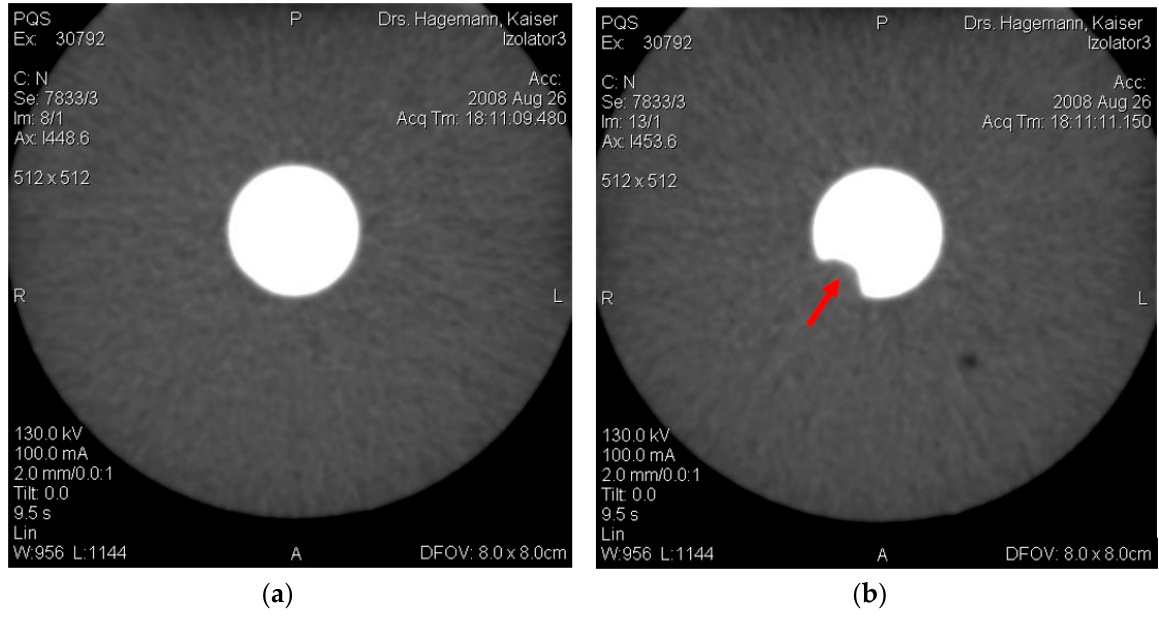
Figure 13. X ‐ ray image of the insulator (selected cross ‐ sectional planes): ( a ) part of the core without Figure 13. X-ray image of the insulator (selected cross-sectional planes): ( a ) part of the core without a a defect and ( b ) core with a visible structure defect (marked with an arrow). defect and ( b ) core with a visible structure defect (marked with an